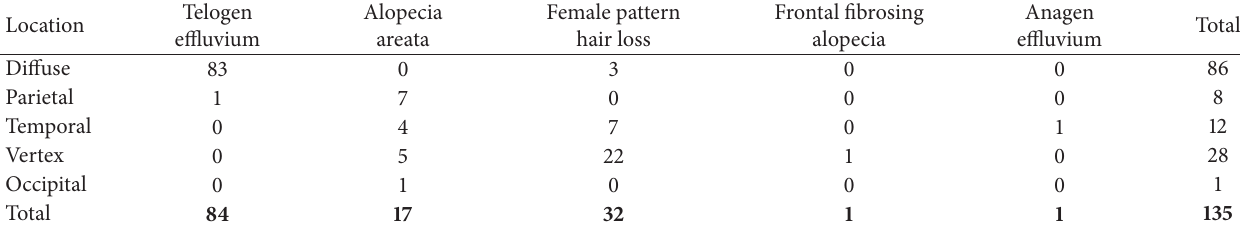
Table 2: Location of